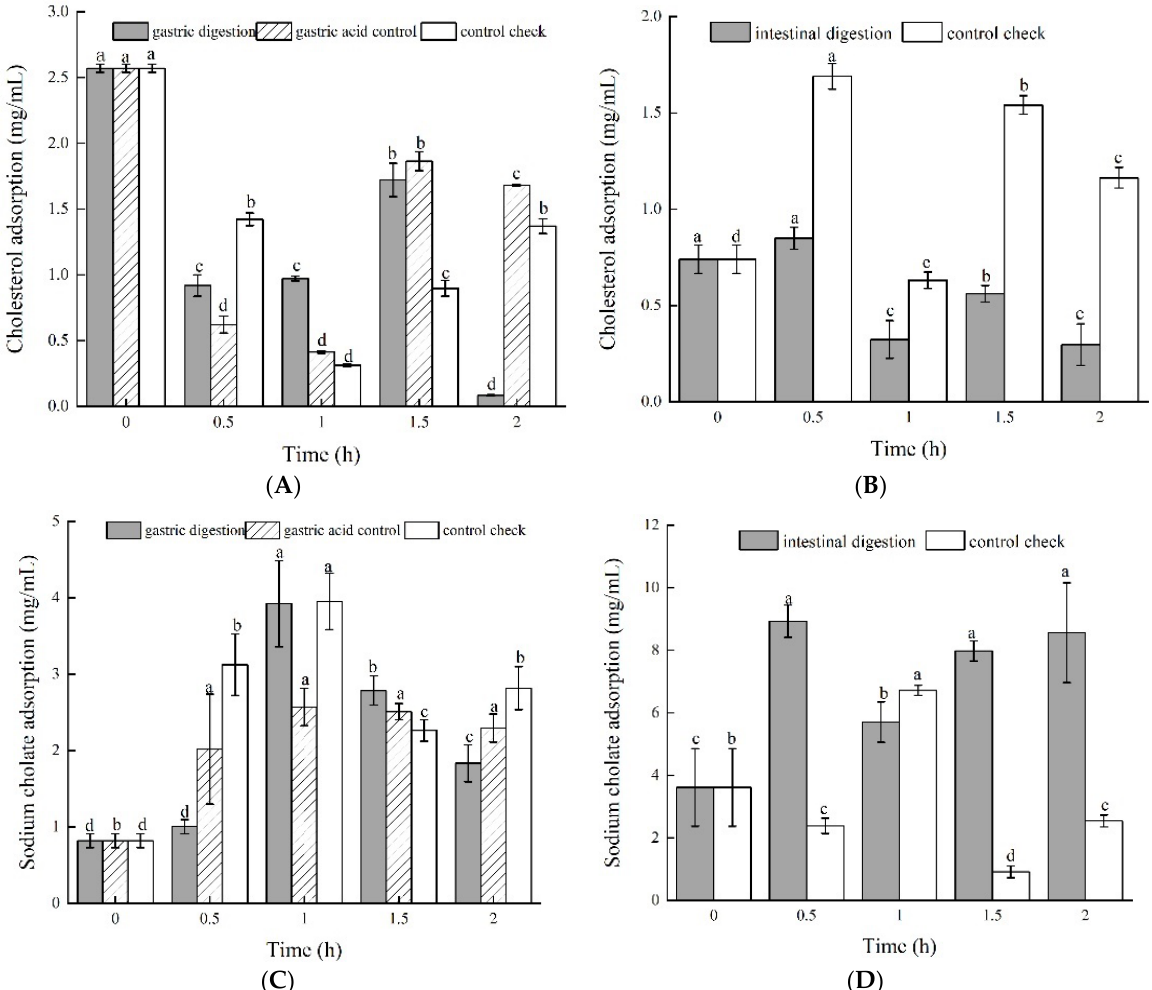
Figure 3. Hypolipidemic activity of green jujube vinegar during in vitro gastrointestinal digestion, ( A , B ) cholesterol adsorption; ( C , D ) sodium cholate adsorption.